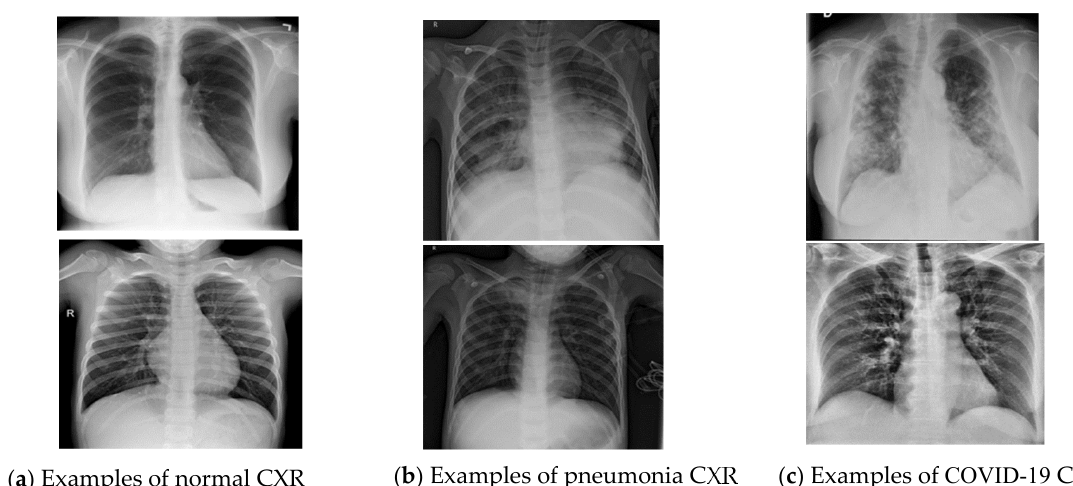
Table 1. COVID-19 RADIOGRAPHY DATABASE (version 2).